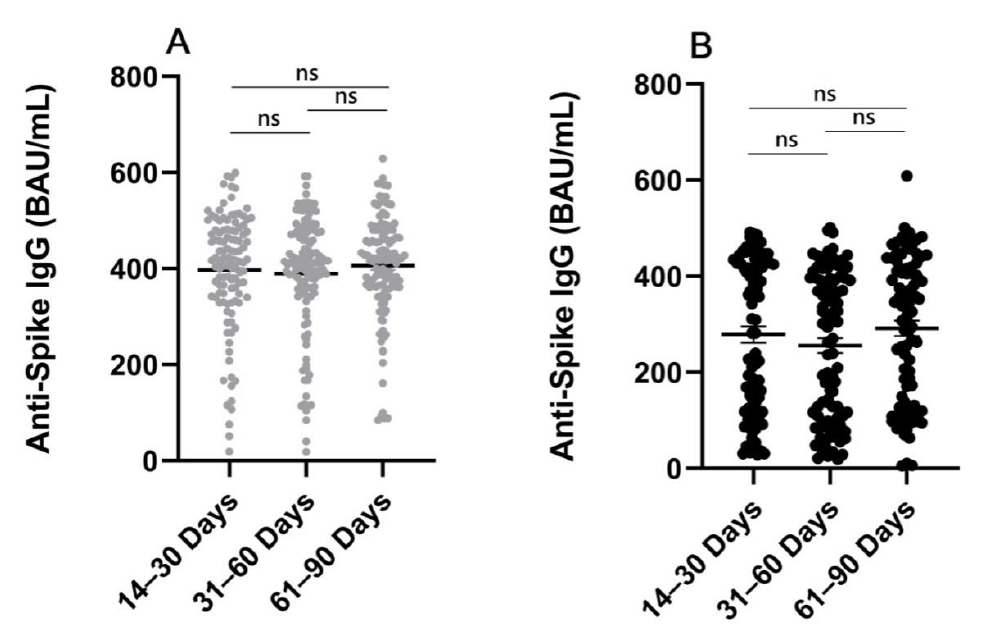
Figure 3. Dynamics of anti-spike IgG levels after complete vaccination. ( A ) There are no significant differences in the quantitative level of anti-spike IgG at different time points (14–30 days, 31–60 days, and 61–90 days) among the 18–59-year group ( p > 0.1 between groups). The means and SEM are shown. ( B ) There are no significant differences in the quantitative levels of anti-spike IgG at different time points (14–30 days, 31–60 days, and 61–90 days) in the ≥ 60-year group ( p > 0.1 between groups). The means and SEM are shown. SEM, standard error of the mean. ns, not significant.